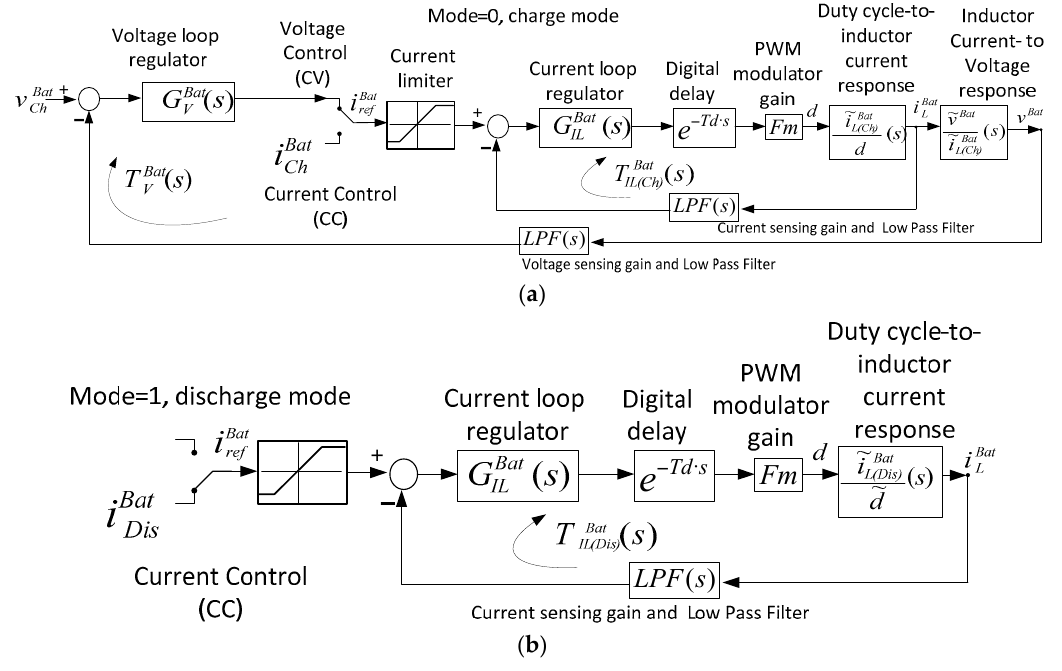
Figure 5. Control structure of the current control loop and of the voltage control loop of the batteries: ( a ) Charge Mode and ( b ) Discharge Mode.